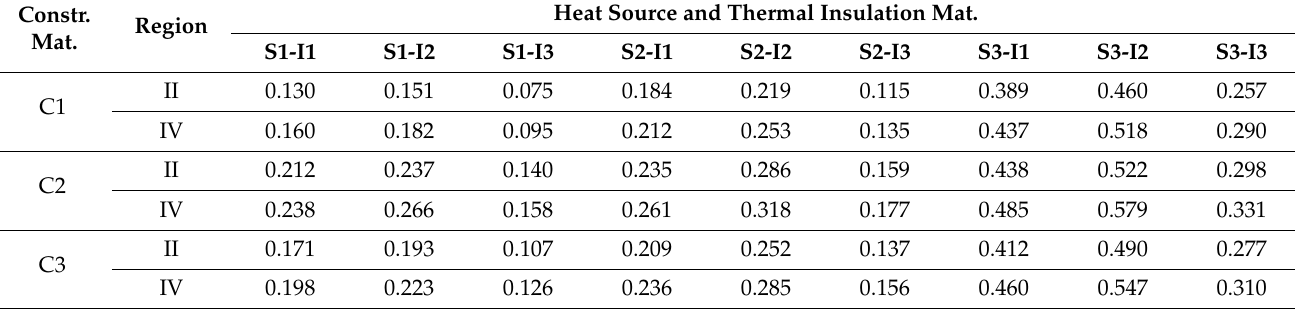
Table 10. Optimum insulation thicknesses d MKopt (m).